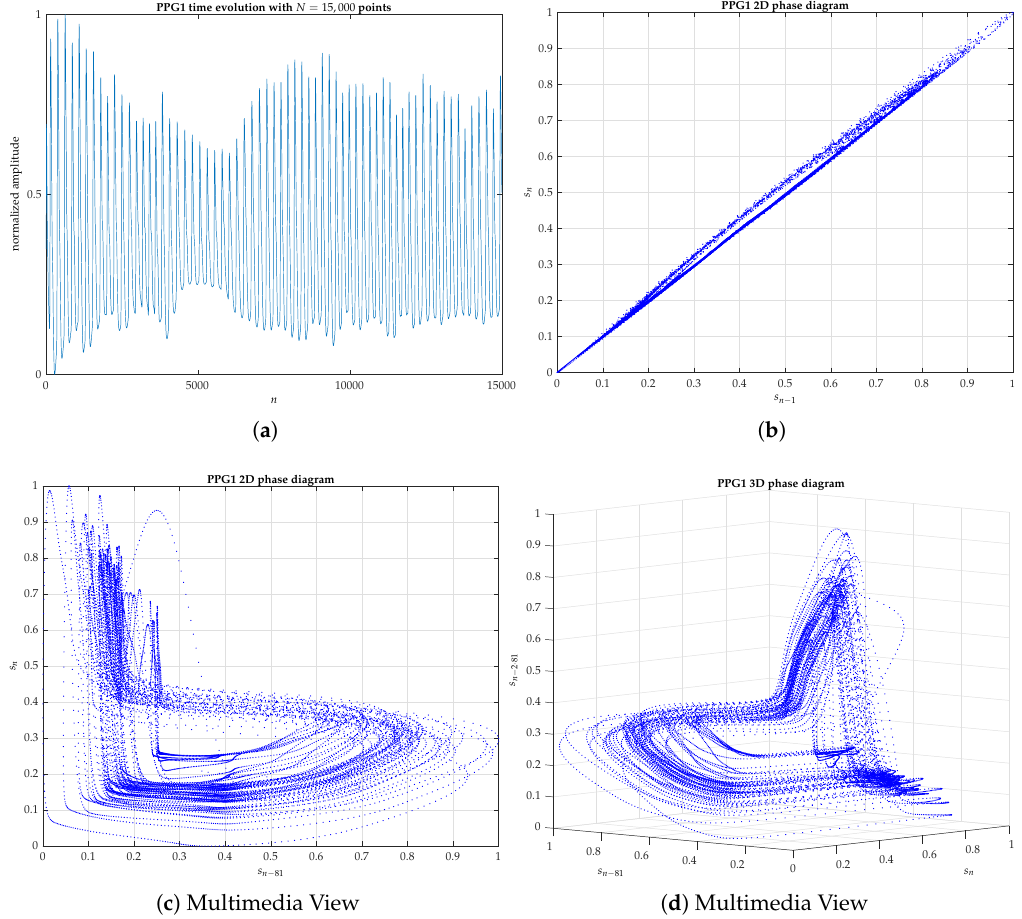
Figure A4. PPG signal of the healthy young Subject Number 1 (PPG1): ( a ) One minute PPG recorded signal. ( b ) PPG1 2D phase diagram with τ = 1. ( c ) PPG1 2D phase diagram with τ = 81, according to Table 1. PPG1 video clip of the evolution of phase diagram from τ = 1 to τ = 150 in 2D. ( d ) PPG1 3D phase diagram with τ = 81. PPG1 video clip of the evolution of phase diagram from τ = 1 to τ = 150 in 3D.